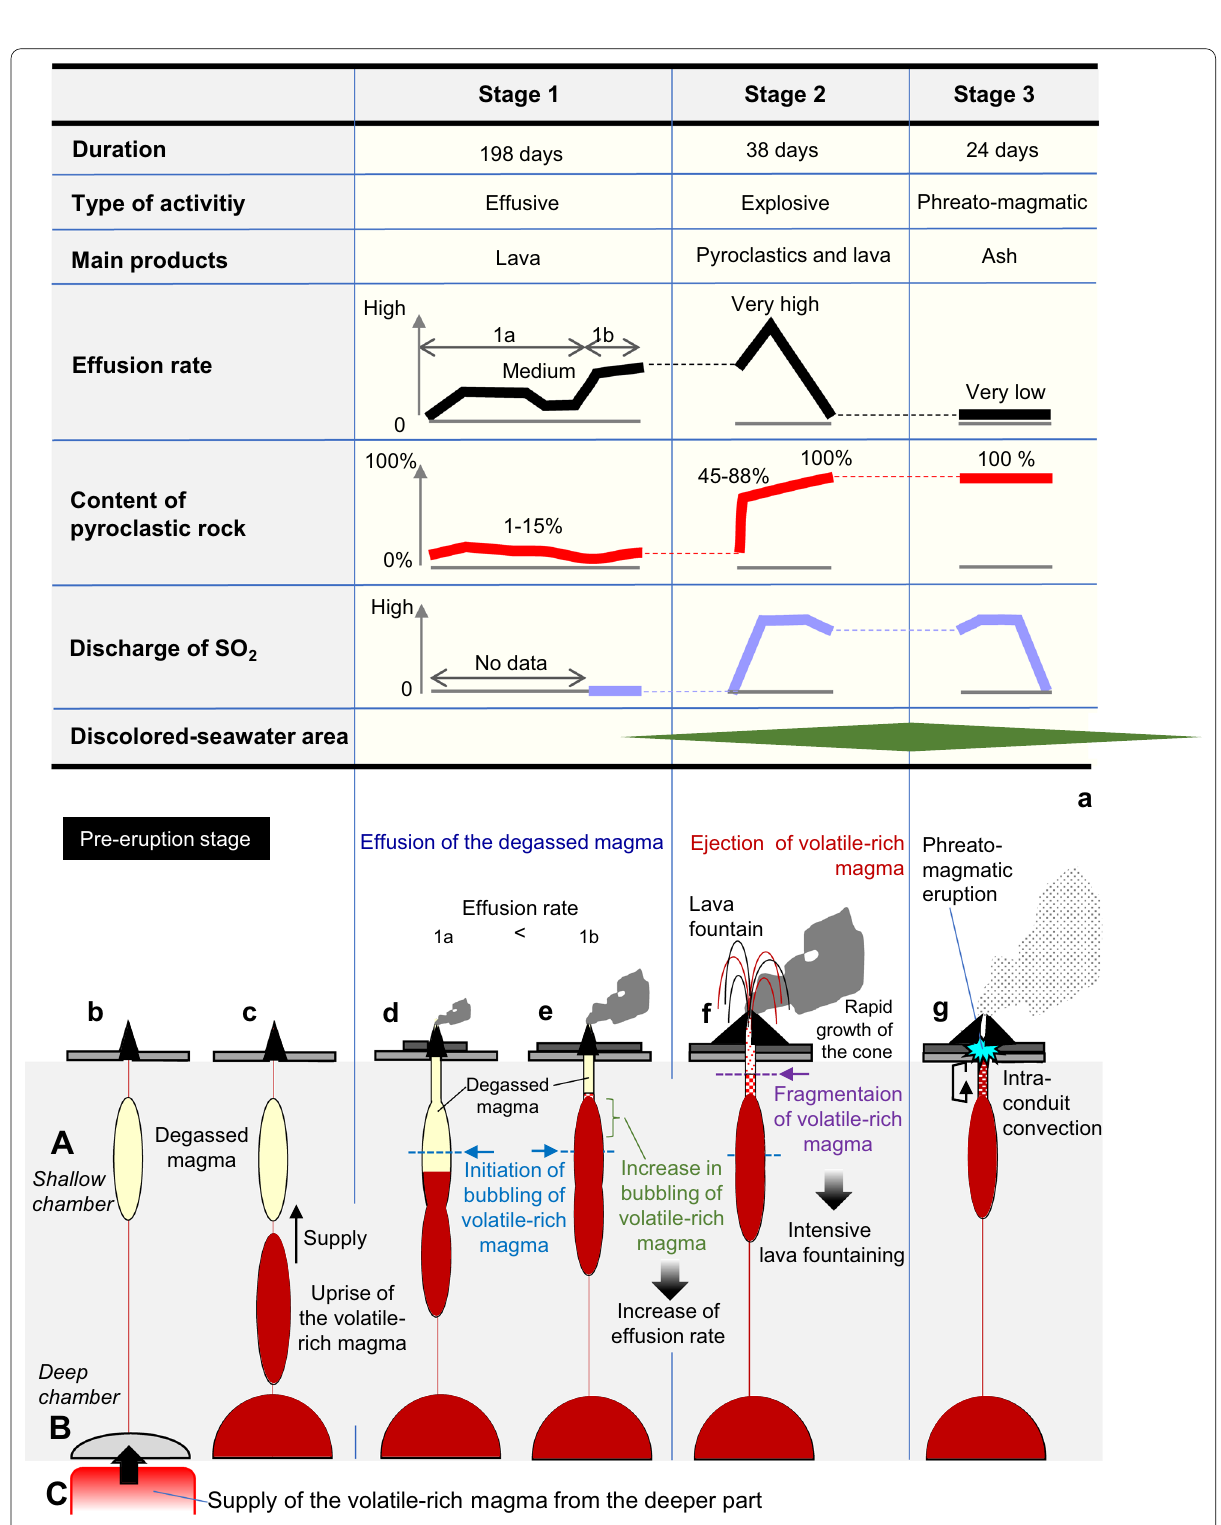
Fig. 7 a Summary of the eruption sequence of the Episode 4 activity of Nishinoshima. b–g Possible model to explain the high effusion rate and abrupt transitions in the eruption modes of Episode